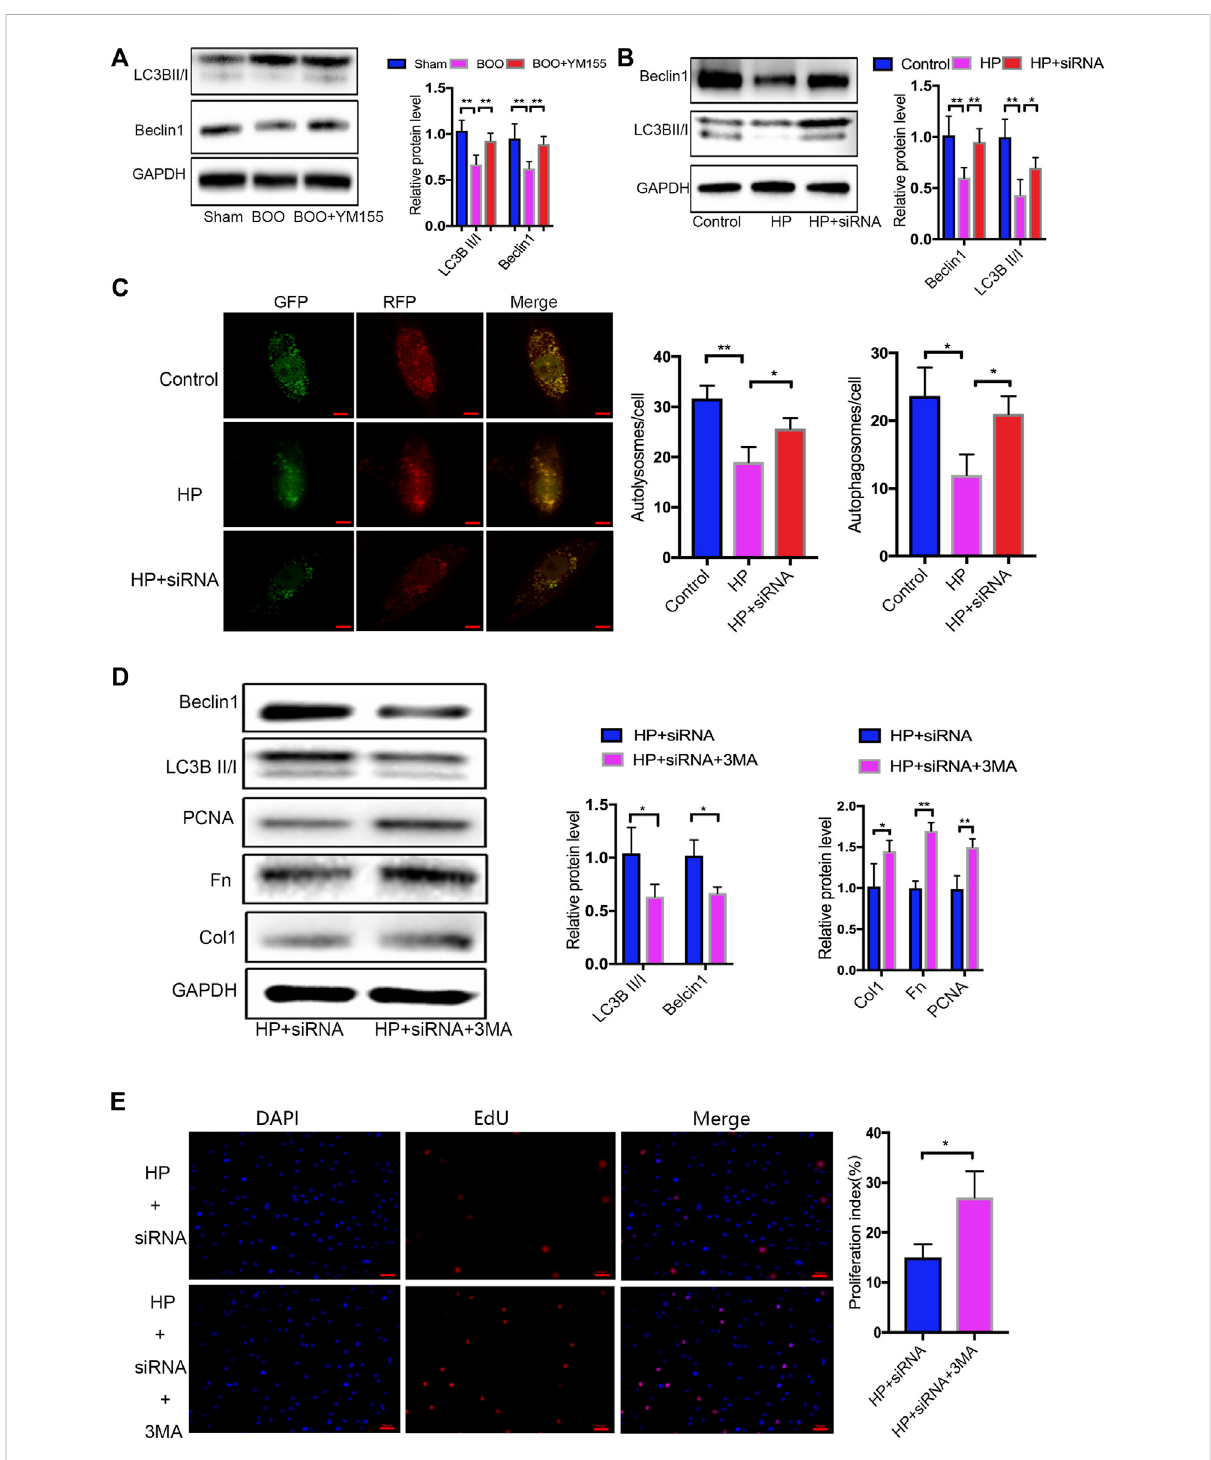
FIGURE 5 Increased survivin by HP led to proliferative and fi brotic response through autophagy. (A) YM155 increased the autophagy markers of the BOO bladderwall( n =8). (B) siRNAsurvivinattenuatedthedecreasedautophagyofhBSMCsinducedbyHP,whichwasevidencedbyincreasedLC3BIIand beclin1 ( n = 3). (C) GFP-mRFP-LC3B assay evaluated whether autophagic fl ux was unobstructed. (D) 3-MA decreased the siRNA survivin-increased autophagy level as well as the siRNA survivin-decreased Col1, Fn, and PCNA expression ( n = 3). (E) EdU assay was used to determine the proliferation of hBSMCs ( n = 3). Data are presented as the mean ± SD, ** p < 0.01; *p < 0.05 ; [ANOVA for (A) ; Kruskal-Wallis 1-way ANOVA for (B – E) ]. Scale bar: 20 μ m for (C) and 50 μ m for (E)